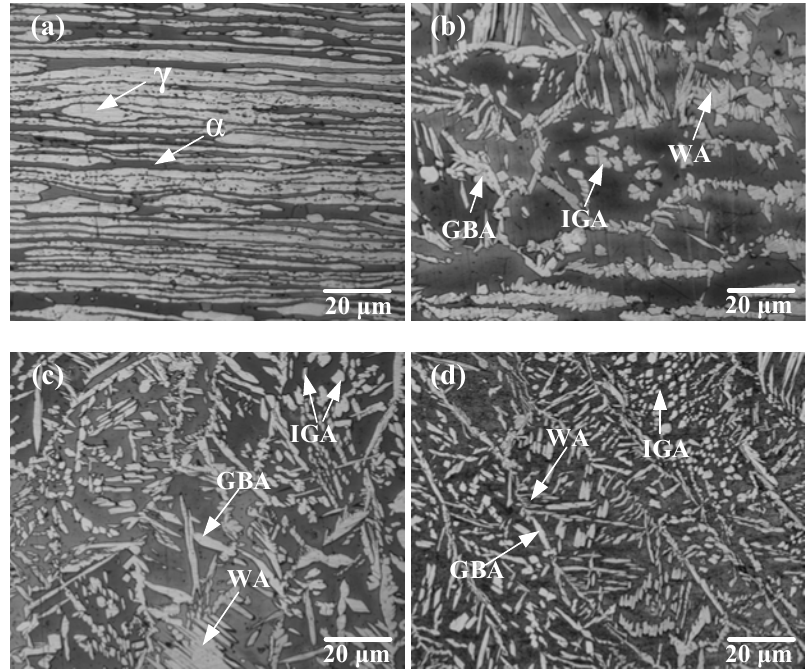
Figure 5. The microstructure of the ULK-TIG welded joint and onshore WM: ( a ) BM, ( b ) heat-a ff ected zone (HAZ), ( c ) underwater WM and ( d ) onshore